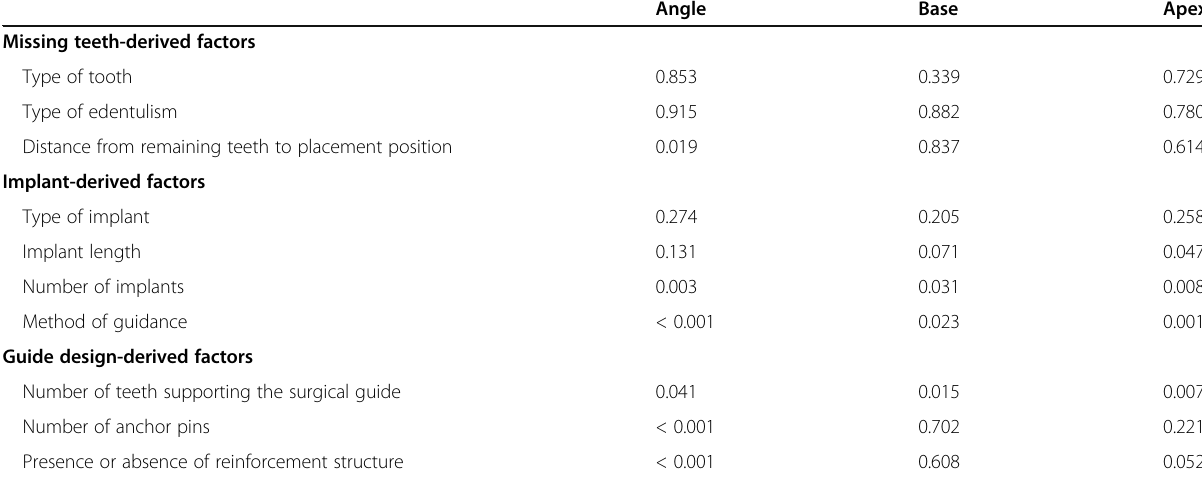
Angle Base Apex